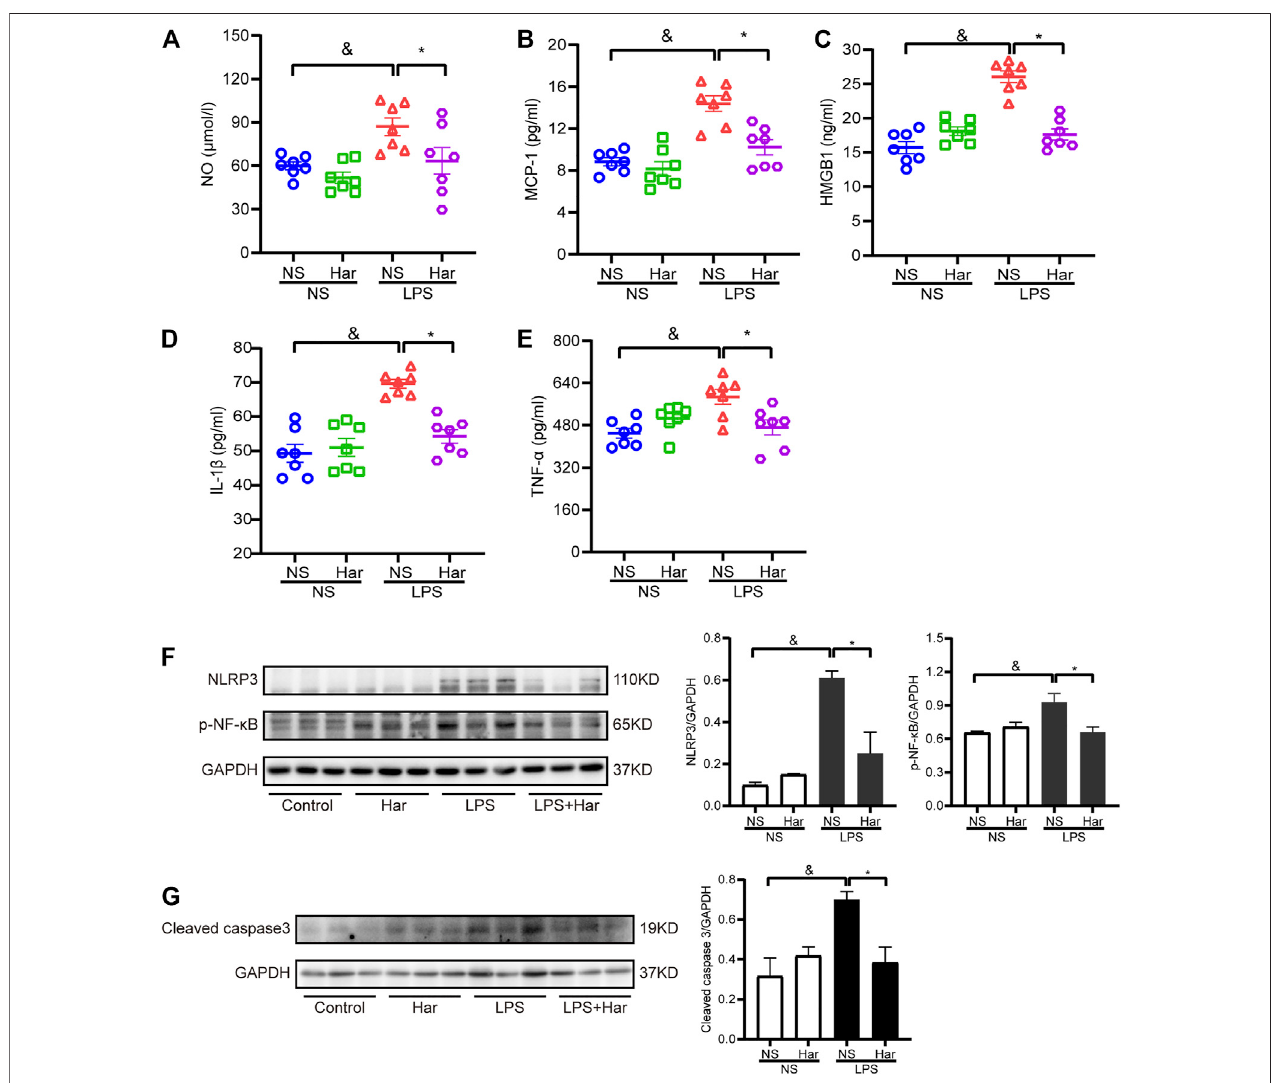
FIGURE 6 | Harmine suppressed sepsis-induced systemic and cardiac in fl ammation. Levels of the following in fl ammatory mediators were detected in mouse plasma: (A) Nitric oxide (NO), (B) MCP-1, (C) HMGB1, (D) IL-1 β , and (E) TNF- α . [ (A – E) , n (cid:1) 7 mice per group]. (F) Levels of the NLRP3 ( n (cid:1) 3) and p-NF- κ B ( n (cid:1) 3) proteins. (G) Levelsofthecleavedcaspase3protein( n (cid:1) 3).GAPDHwasusedasinternalcontrolforwesternblotting.Dataarepresentedasthemeans ± SEM, & p < 0.05 compared with the control group; * p < 0.05 compared with the LPS